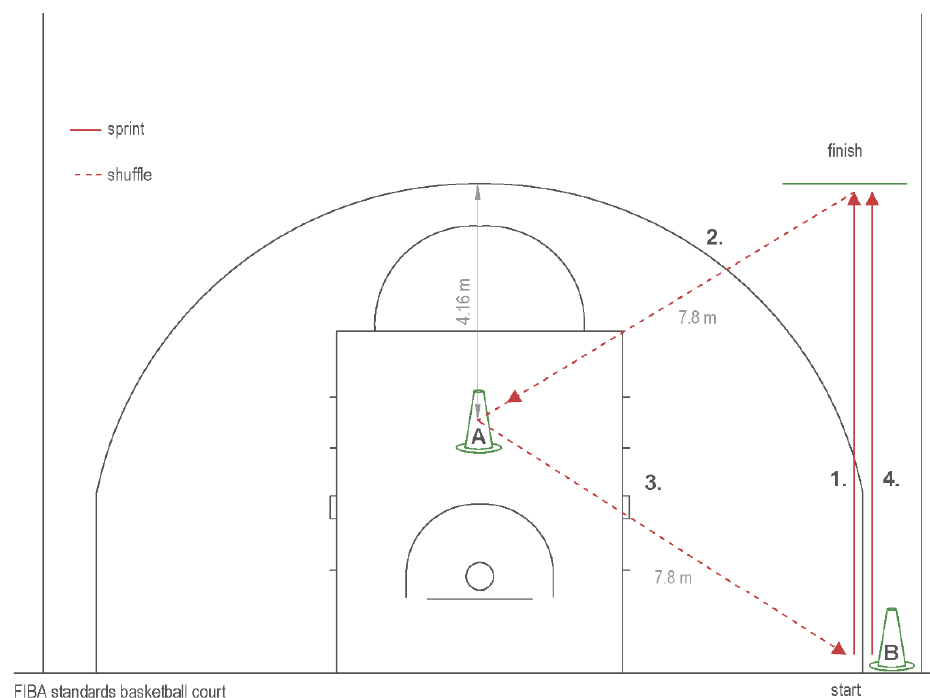
Figure 7. Reactive Shuffle Test. An average shuttle test with reactive starts (light signals); adapted and edited from [18].